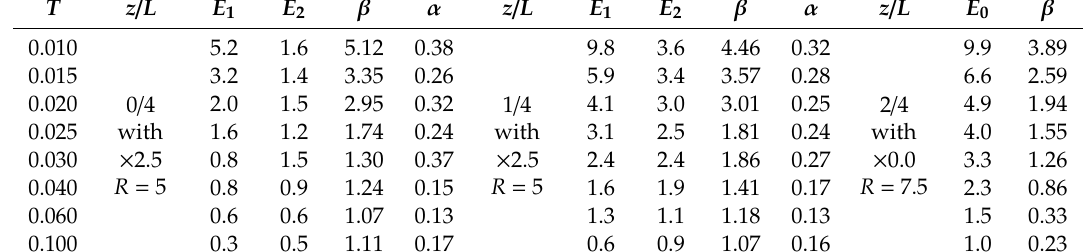
related to the thickness of the shell. Also,